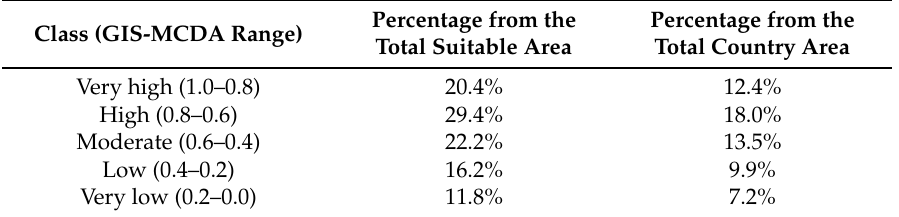
Table 2. Percentage area by category for the suitable areas and total country area. Class (GIS ‐ MCDA Range)